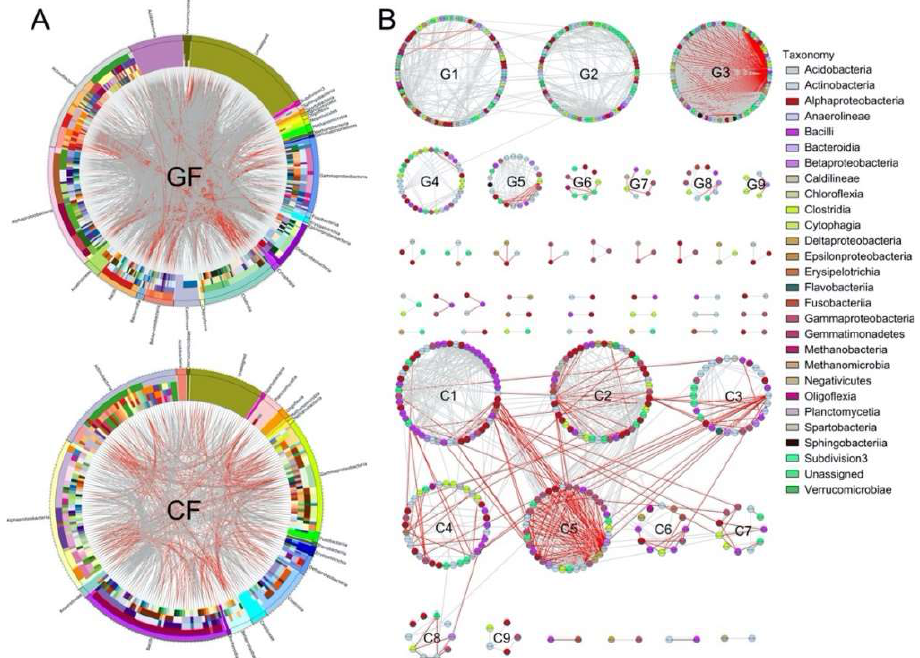
Figure 5. Circular plot ( A ) and ecological network ( B ) descriptions of the interaction between species within intestinal bacterial community. The width of the bars represents the abundance of each taxon. The bands with different colors demonstrate the source of different genera. The taxonomic levels were class, order, family, genera, and species from the outside to the inside of the circle. Each node in the network graph indicates one OTU. Colors of the nodes indicate different major classes. The edges (gray edge = positive interaction and red edge = negative interaction) inside the circle and ecological network represent the interactions between species. Table 2. The composition of the ecological network.